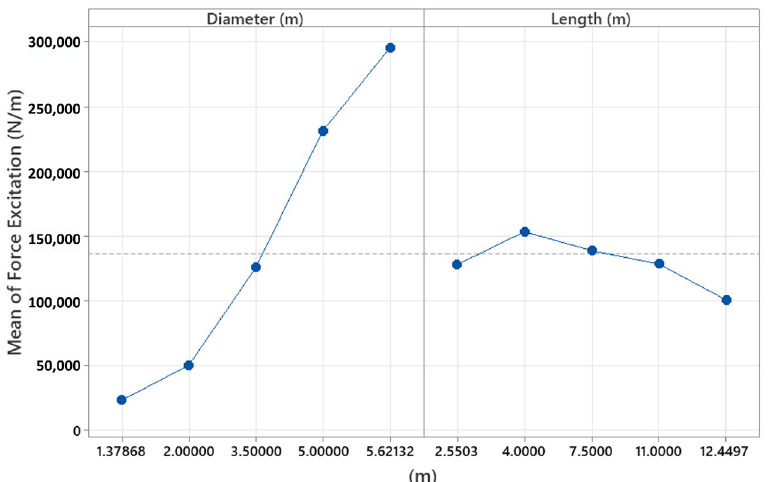
Figure 14. Main Effect Diagram for Force Excitation.